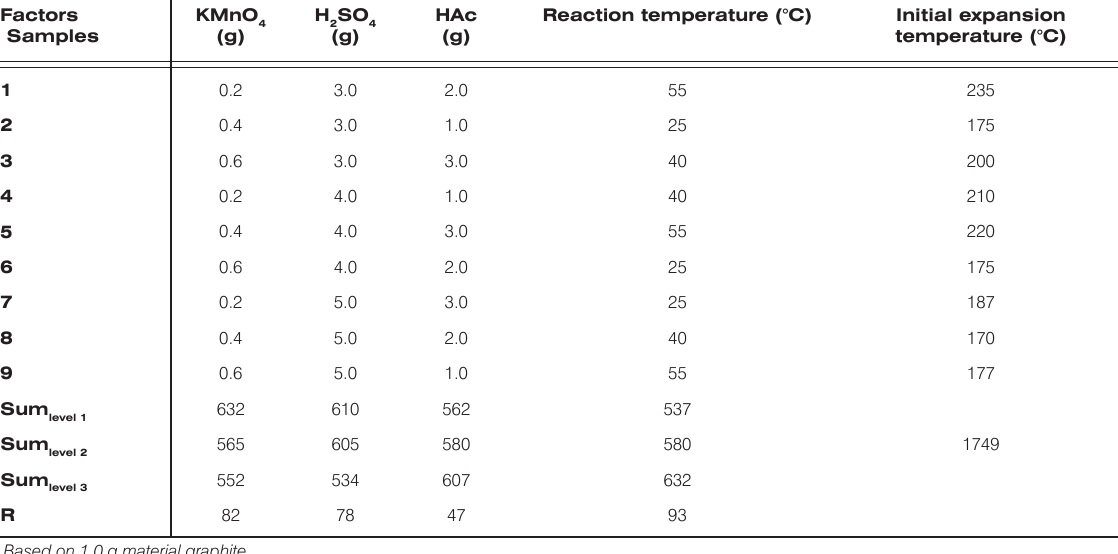
Table 3. L (3 4 ) orthogonal test results of EG initial expansion temperature b . 9